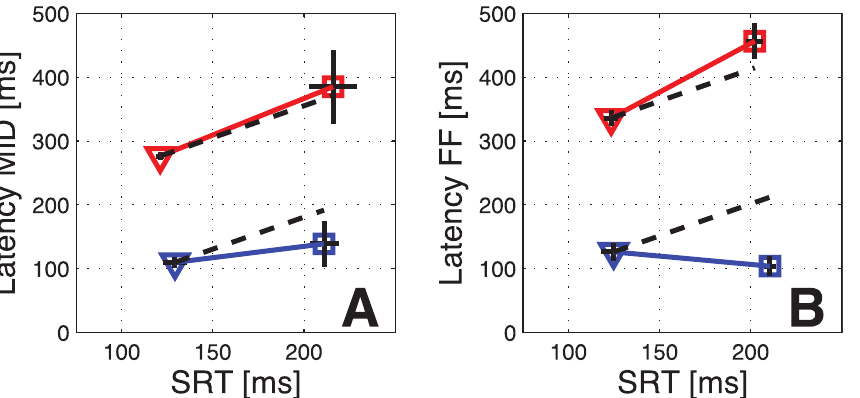
Figure 6. Relationship between saccadic reaction times and extraclassical response latencies. Comparison between the mean saccadic reaction times (SRTs) and the mean latencies of the early (blue) and the late (red) extraclassical responses to MID-probes (A) and FF-probes (B). The latencies are calculated relative to the onset of the visual probe. The results for the two monkeys are shown separately. Monkey 2 (squares) had on average , 80 ms longer SRTs than monkey 1 (triangles). Black horizontal and vertical lines placed in the markers indicate the SEM of the SRTs and of the neuronal latencies. Dashed black lines show the expected increase in remapping latency that would result from shifting the extraclassical response latency on each trial by an amount equal to the mean SRT.